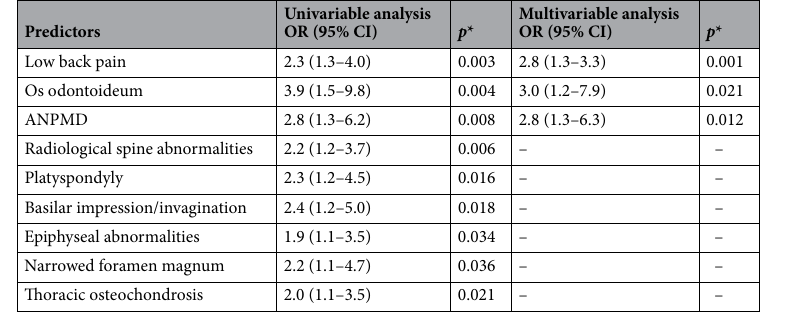
Table 8. Predictors of CNS injury in genetic skeletal disorder patients. R 2 = 10.9%; Hosmer–Lemeshow test = 0.995. CNS central nervous system, OR odds ratio, CI confidence interval, ANPMD abnormal neuropsychomotor development. *X 2 test or Fisher’s exact